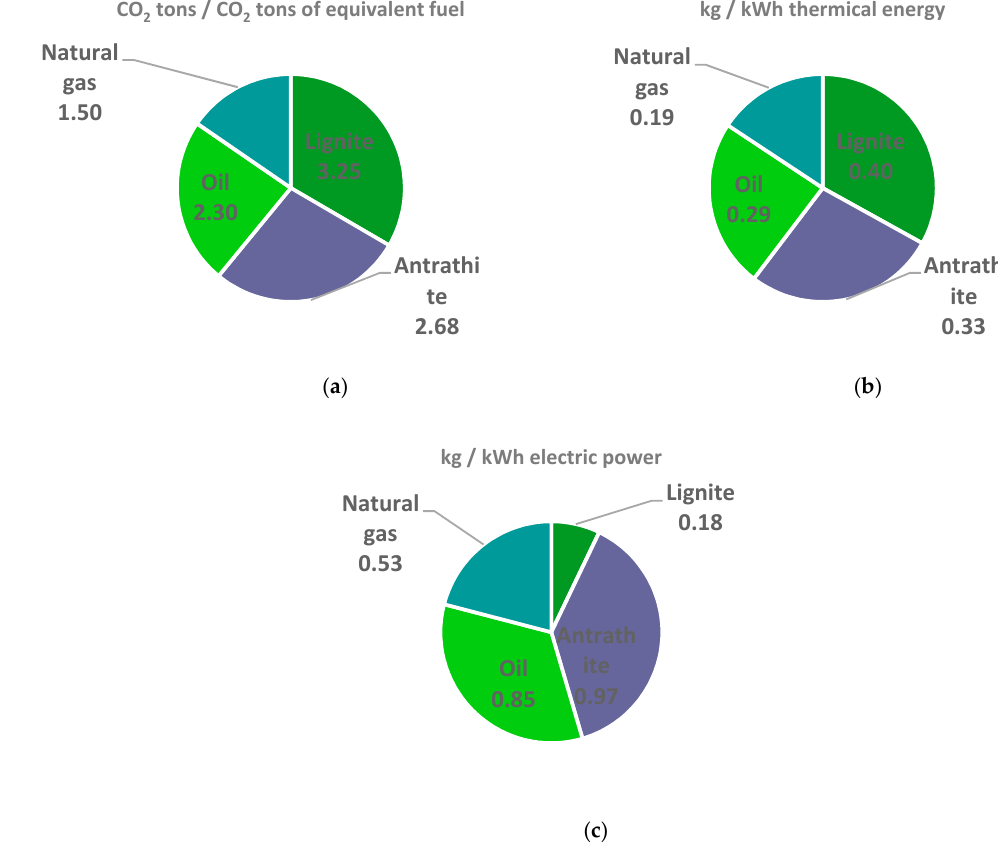
Figure 3. CO 2 emissions distribution depending on fuel type and the studied parameters. ( a ) CO 2 tons/CO 2 tons of equivalent fuel, ( b ) kg/kWh thermal energy, ( c ) kg/kWh electric power.